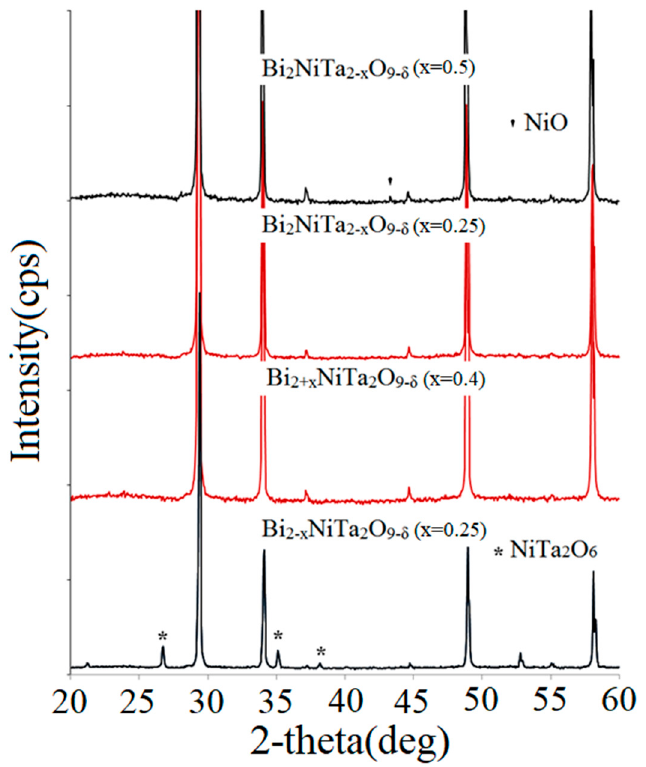
Figure 2. X-ray powder diffraction patterns of Bi 2 − x NiTa 2 O 9 − δ , Bi 2+x NiTa 2 O 9+ δ , and Bi 2 NiTa 2 − x O 9 − δ samples at different x values.